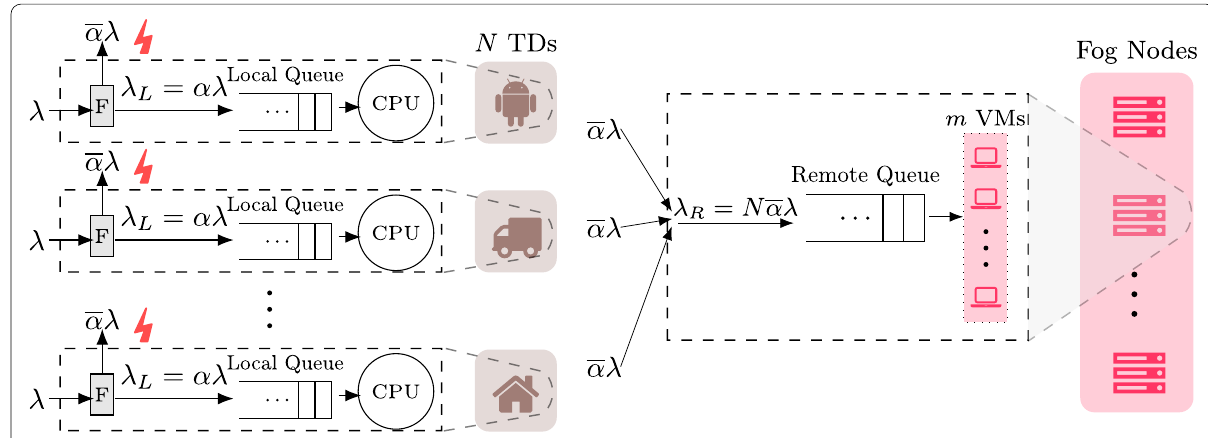
Fig. 2 Proposed queueing model. It comprises an M/G/1 queue at the TD and an M/G/ m queue at the fog. The forwarder F offloads long tasks to the fog for remote processing, and retains short tasks at the TD for local